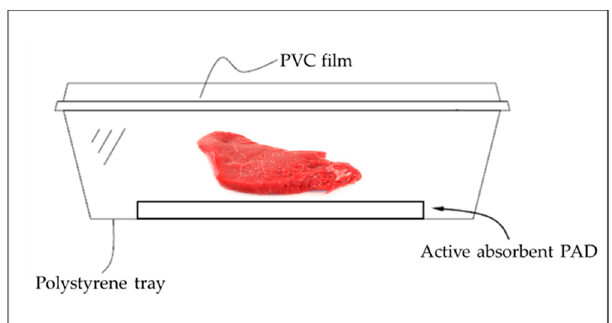
Figure 1. Conformation of the packages where the meat slices were storage.